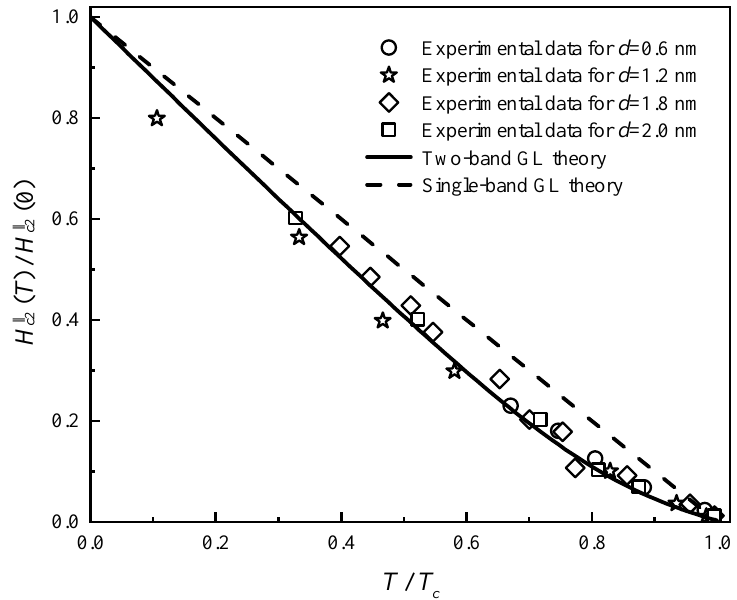
Figure 1. The temperature dependence of normalized upper critical magnetic field parallel to the c -axis for the NbSe 2 thin film. The experimental data of the NbSe 2 films with the thickness d = 0.6, 1.2, 1.8, and 2.0 nm are taken from Refs. [9,15].